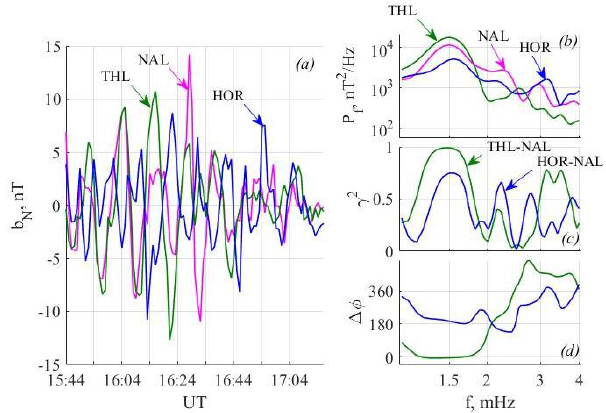
Figure 5. (a) Pulsations of the b N component at NAL, THL, and HOR during the interval starting at 15:44UT; (b) the PSD spectra; (c) the spectral coherence for the THL–NAL and HOR–NAL station pairs; and (d) the phase differences are shown. The THL–NAL and HOR–NAL station pairs in panels (c) and (d) are shown using the same respective colours as THL and HOR in panels (a) and (b)